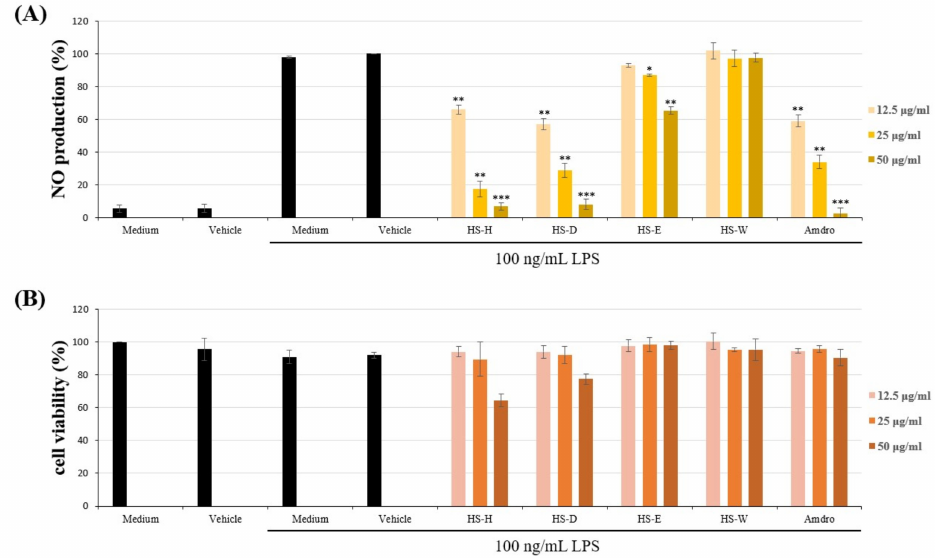
Figure 1. E ff ects of di ff erent partition fractions (HS-H, HS-D, HS-E and HS-W represent n -hexane, dichloromethane, ethyl acetate and H 2 O fractions, respectively) of crude MeOH extracts from Hypericum sampsonii on ( A ) nitric oxide (NO) production and ( B ) cytotoxicity in lipopolysaccharide (LPS)-induced RAW264.7 macrophages. Data expressed as means ± SEM (n = 3). Asterisks indicate significant di ff erences (* p < 0.05, ** p < 0.01 and *** p < 0.001) from the (media + DMSO + LPS) control